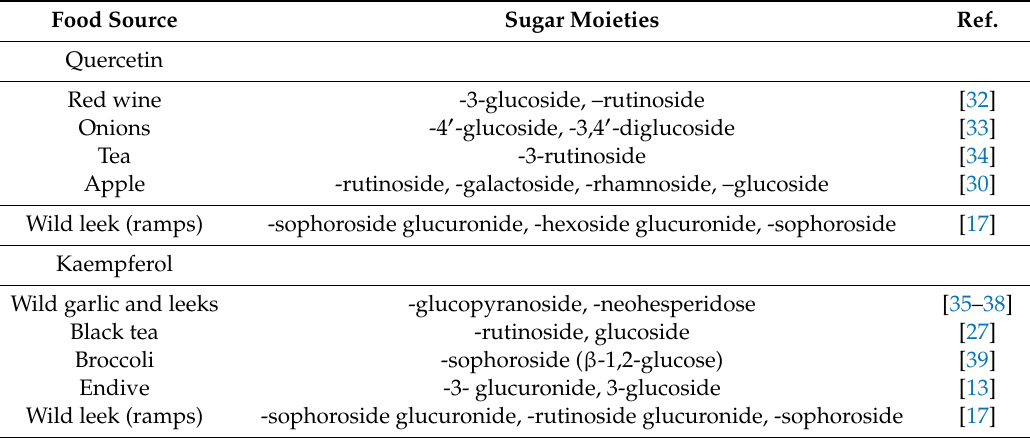
Table 2. Major quercetin and kaempferol glycosides in select plant